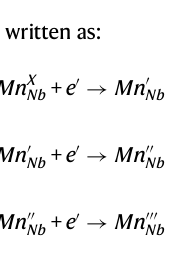
Fig. 1 | Phase transition behavior and energy-storage performance of NaNbO 3 - based antiferroelectrics and relaxors. Polarization hysteresis loops of a NN, b NN5SS, c Mn-modi fi edNN5SS(NN5SS_0.1MnandNN5SS_1.0Mn), d NN7SS_1.0Mn, and e NN9SS_1.0Mn samples, obtained from the 2 nd electric fi eld cycle at 1Hz. f Recoverable energy-storage density and ef fi ciency properties of the investigated